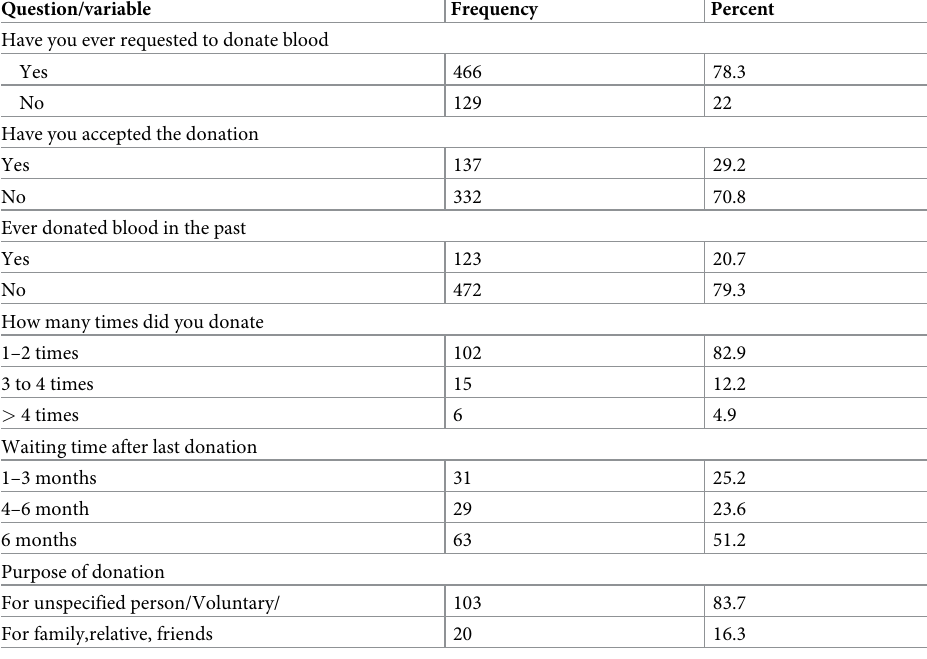
Table 3. Past behavioral practice on voluntary blood